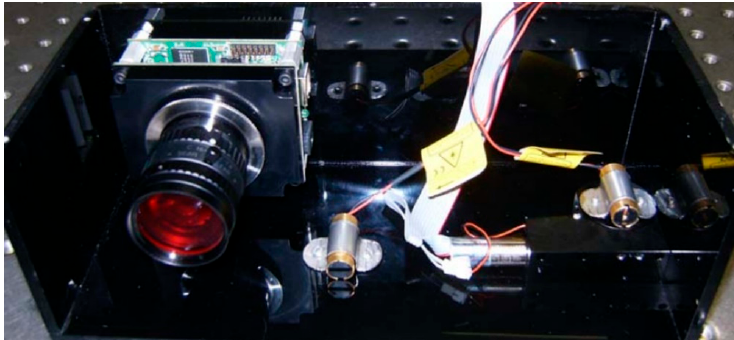
Figure 15. Scanner with camera and two laser light projectors.